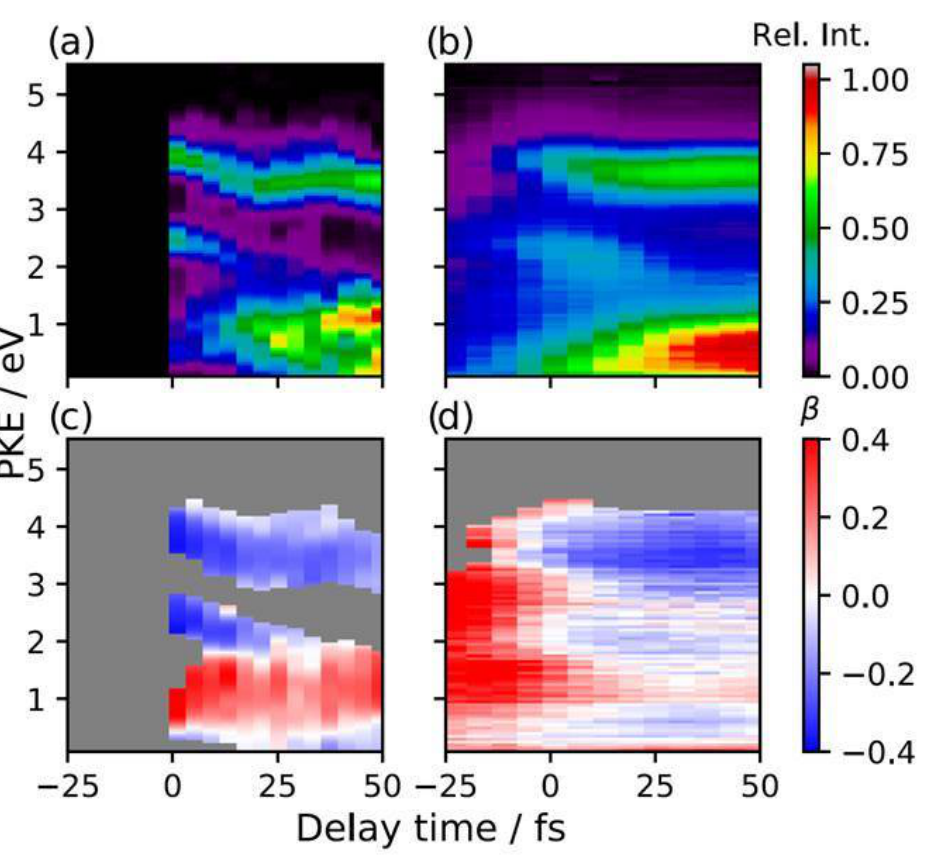
Figure 7. Time resolved photoelectron spectra of pyrazine. Cross section ( upper panels), β parameter ( lower panel). ( a , c ) experimental; ( b , d ) calculated. From [52] with